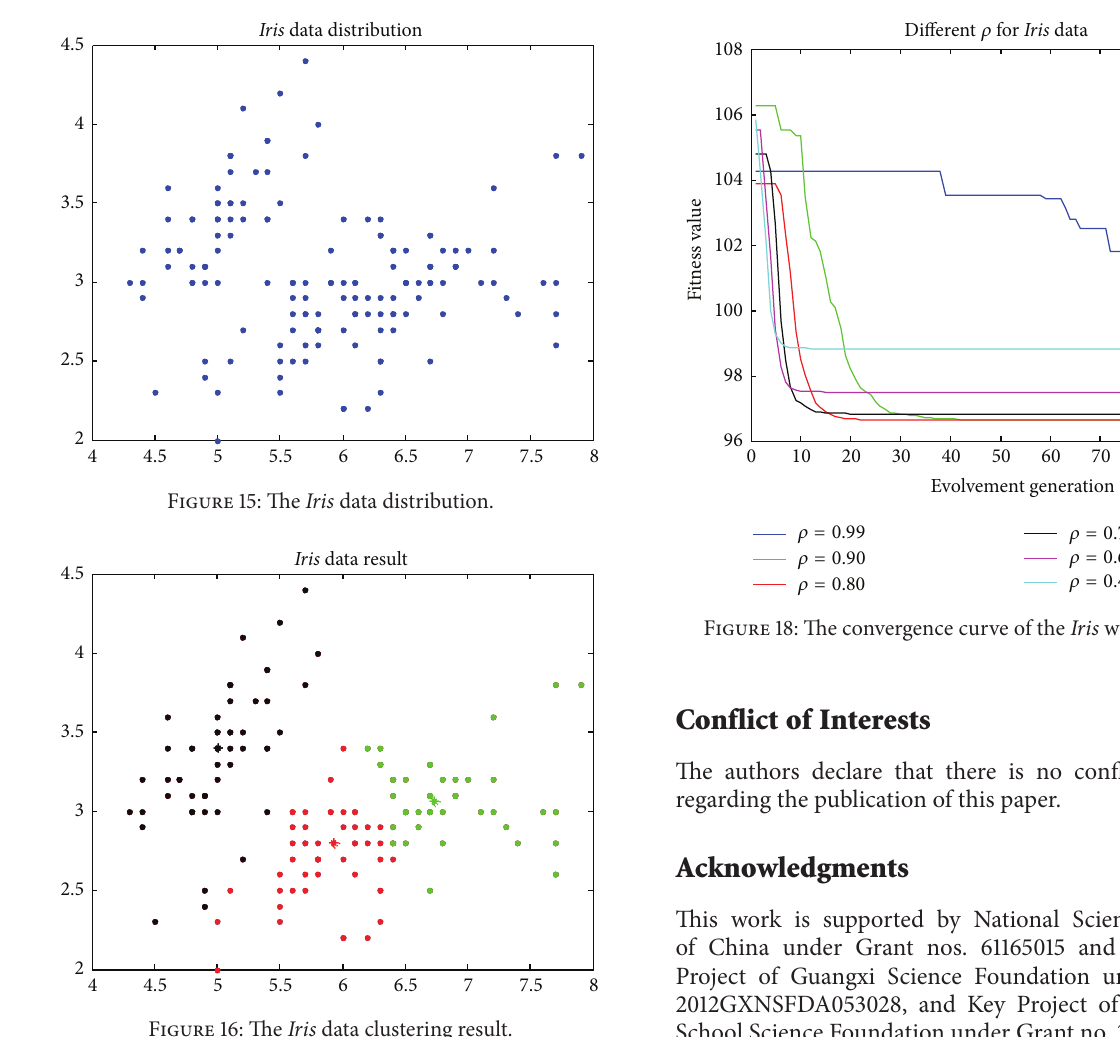
Figure 16: The Iris data clustering result.